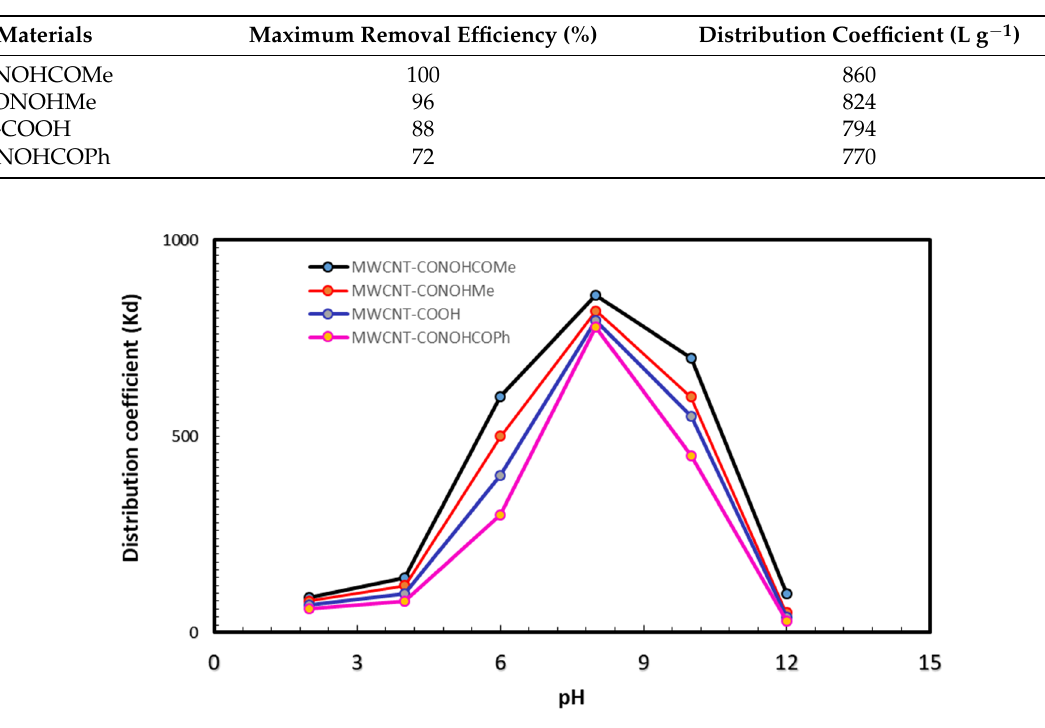
Figure 7. Effect of pH on Pb(II) removal % using 10 mg of functionalized carbon nanotubes and 30 mg/L of Pb(II) at 30 °C for 50 min. Table 2. The prepared adsorbent materials’ performance evaluations for removing Pb(II) at 8 pH and a 100 mgL − 1 metal starting concentration.